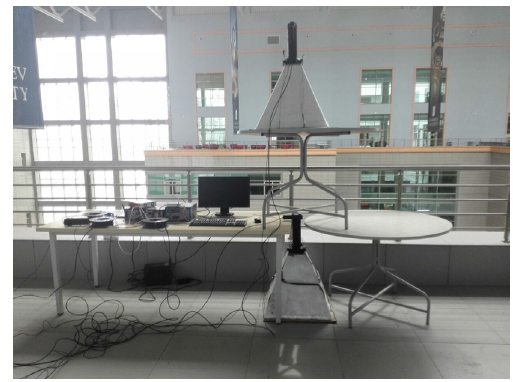
Figure 1. Prototype system under